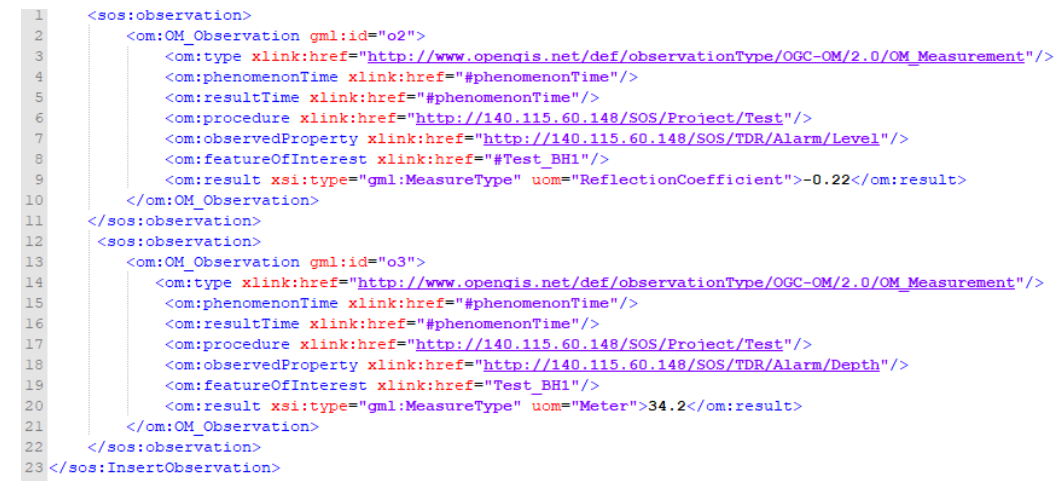
Figure 16. Insert Observation XML request of TDR_Deformation_Observation (Part I).